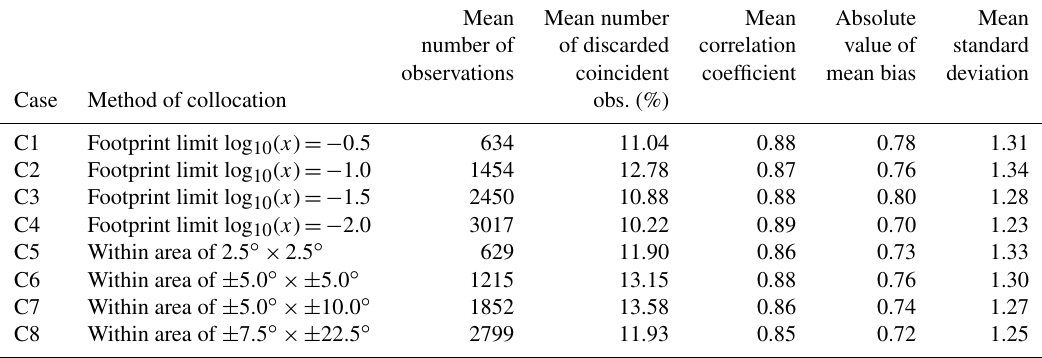
Table 8. Averaged results of different collocation methods implemented for XCO 2 from the GOSAT UoL-FP product calculated for 16 TCCON sites.